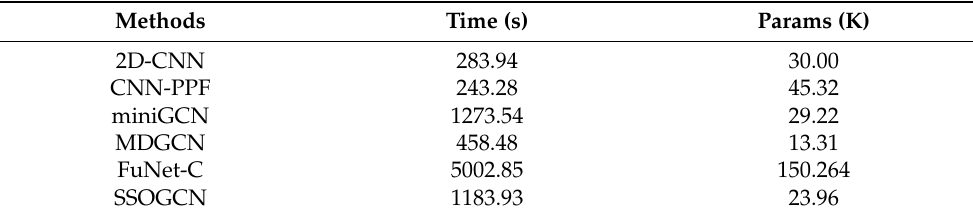
Table 11. Run time comparison and parameter number comparison of depth model in the Salinas University data